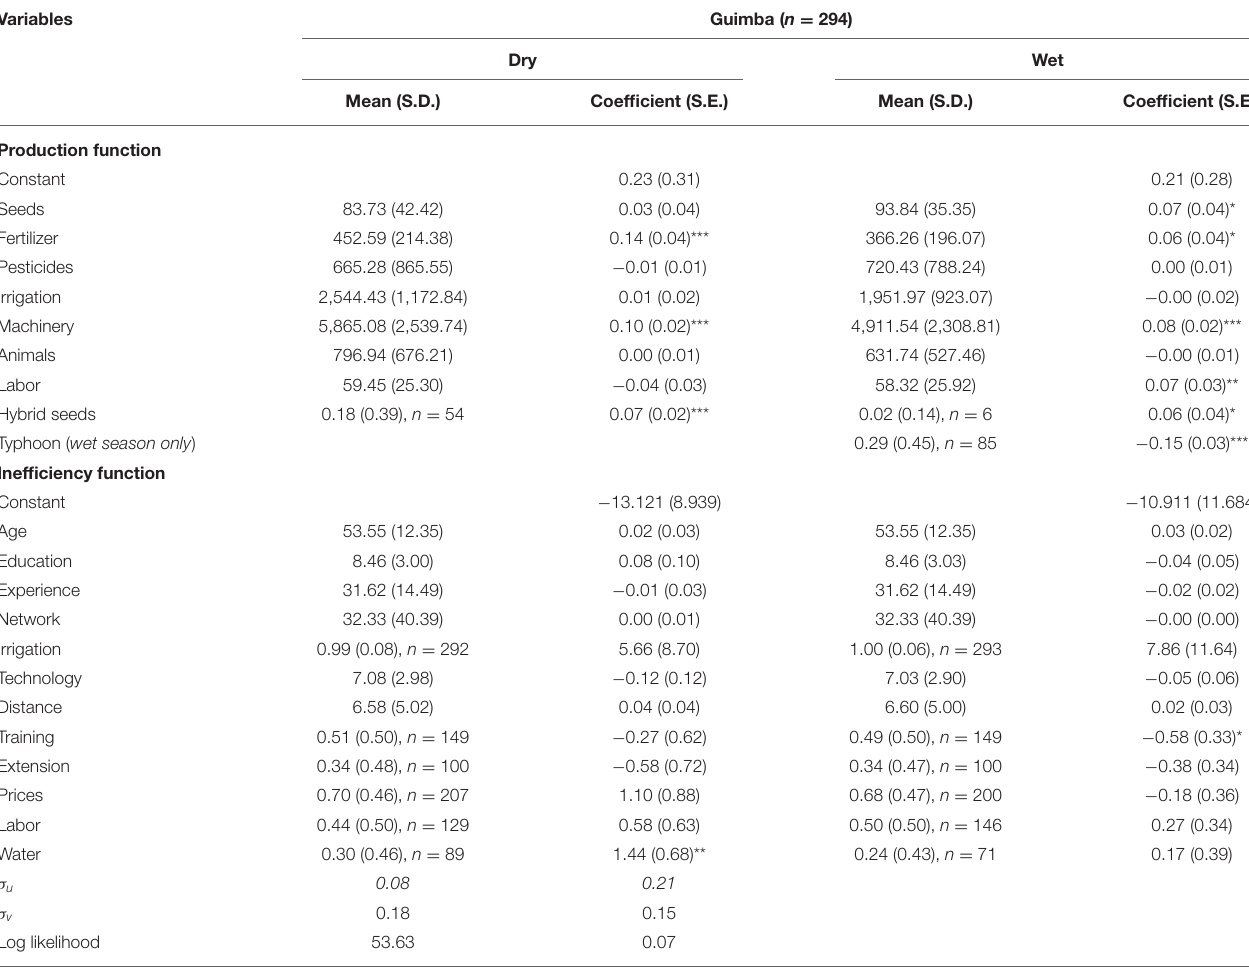
Tabulated data are from the author’s own calculation. The respective coefficients and the standard errors of the coefficients are correct to two significant digits. * Significant at